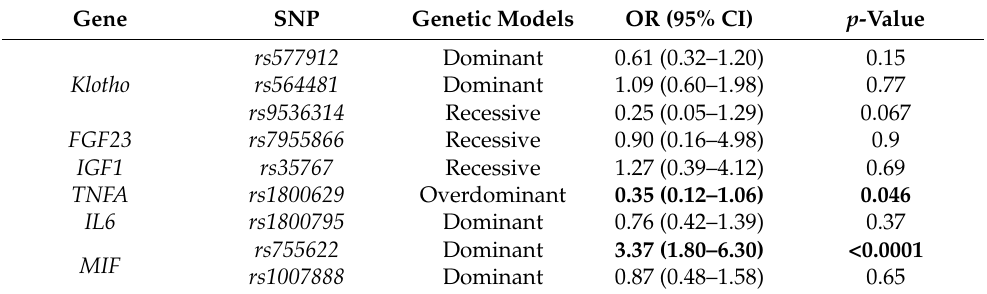
Table 4. Evaluation of SNP associations with ESRD (adjusted by age, gender, hypertension, diabetes, and hypercholesterolemia). Gene SNP Genetic Models OR (95% CI)